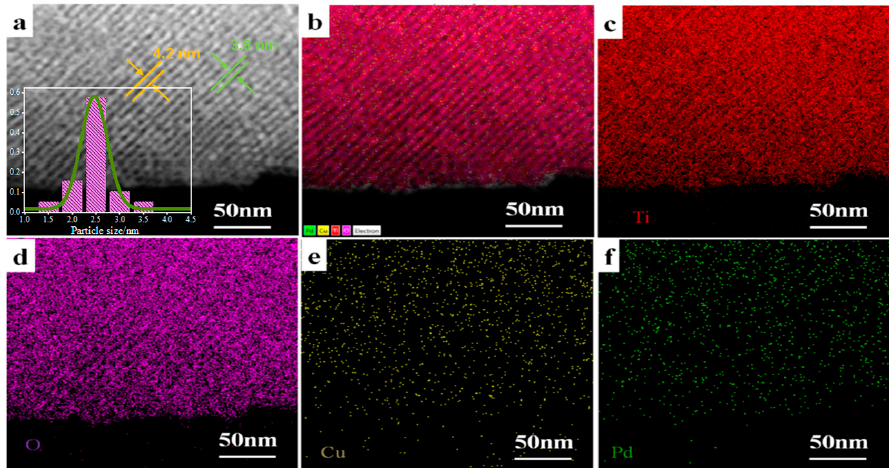
Figure 3. ( a ) HAADF-STEM image for CPT-1.5 and ( b – f ) the corresponding EDS elemental mapping images.